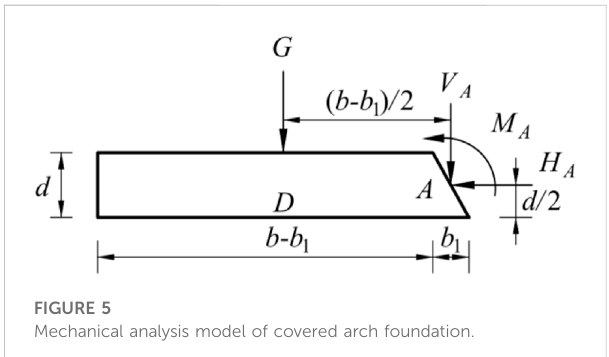
FIGURE 5 Mechanical analysis model of covered arch foundation.